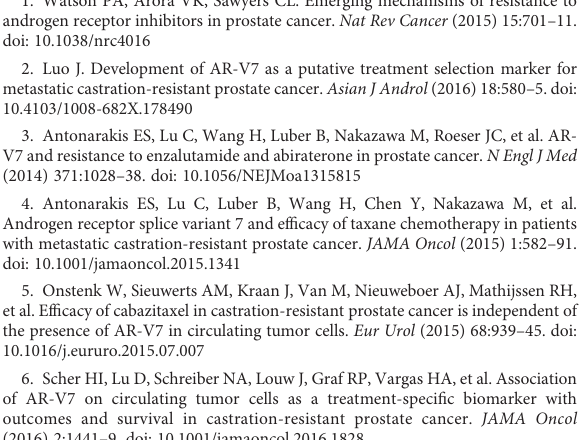
SUPPLEMENTARY FIGURE 1 Relative expression of AR-FL, AR-V7, and GR mRNAs in each patient. SUPPLEMENTARY FIGURE 2 Western blot analysis of AR-FL, AR-V7, and GR protein levels in patient tissue samples. SUPPLEMENTARY FIGURE 3 Best PSA responses in patients treated with taxane chemotherapy. SUPPLEMENTARY FIGURE 4 Receiver operating characteristic curve analysis for prediction of PSA response. SUPPLEMENTARY FIGURE 5 OutcomesinpatientstreatedwithAR-targetingtherapyusingmedianAR- V7/AR-FL andGR/AR-FLratiosin CRPCtissue samples ascutoff points. (A) Best PSA responses. (B) PSA progression-free survival according to AR- V7/AR-FL. (C) PSA progression-free survival according to GR/AR-FL. SUPPLEMENTARY TABLE 1 PSA responses in patients treated with enzalutamide or abiraterone. SUPPLEMENTARY TABLE 2 Logistic regression analyses predicting PSA response in patients treated with AR-targeting